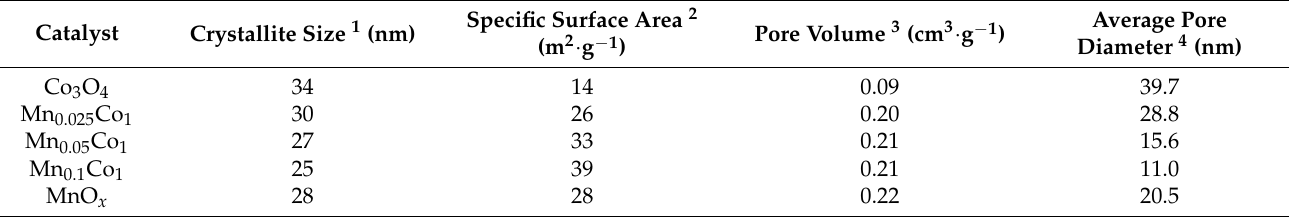
Figure 2. Wide-angle ( a ) and enlarged ( b ) XRD spectra of the Co 3 O 4 and Mn x Co 1 ( x = 0.025, 0.05, 0.1) catalysts and ( c ) a variation in the lattice constant of Co 3 O 4 as a function of the mole ratio of Mn/Co. Table 1. Textual properties of the as-obtained catalysts.